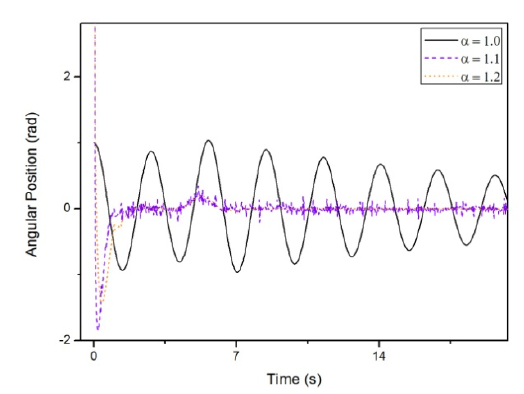
Figure 15. Time history (values of α ≥ 1).